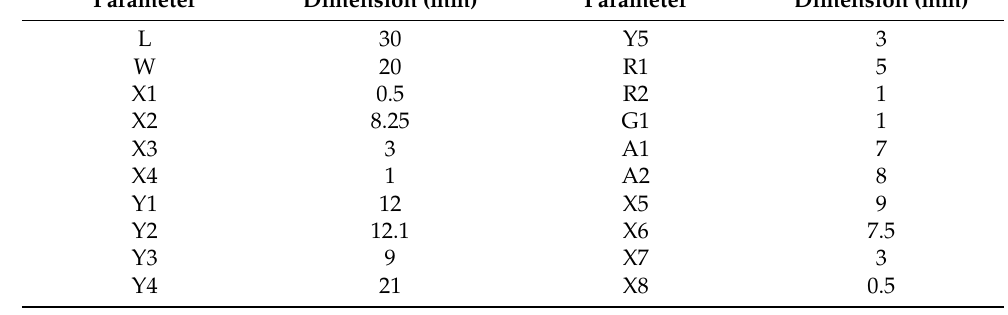
Table 1. Proposed antenna dimension.